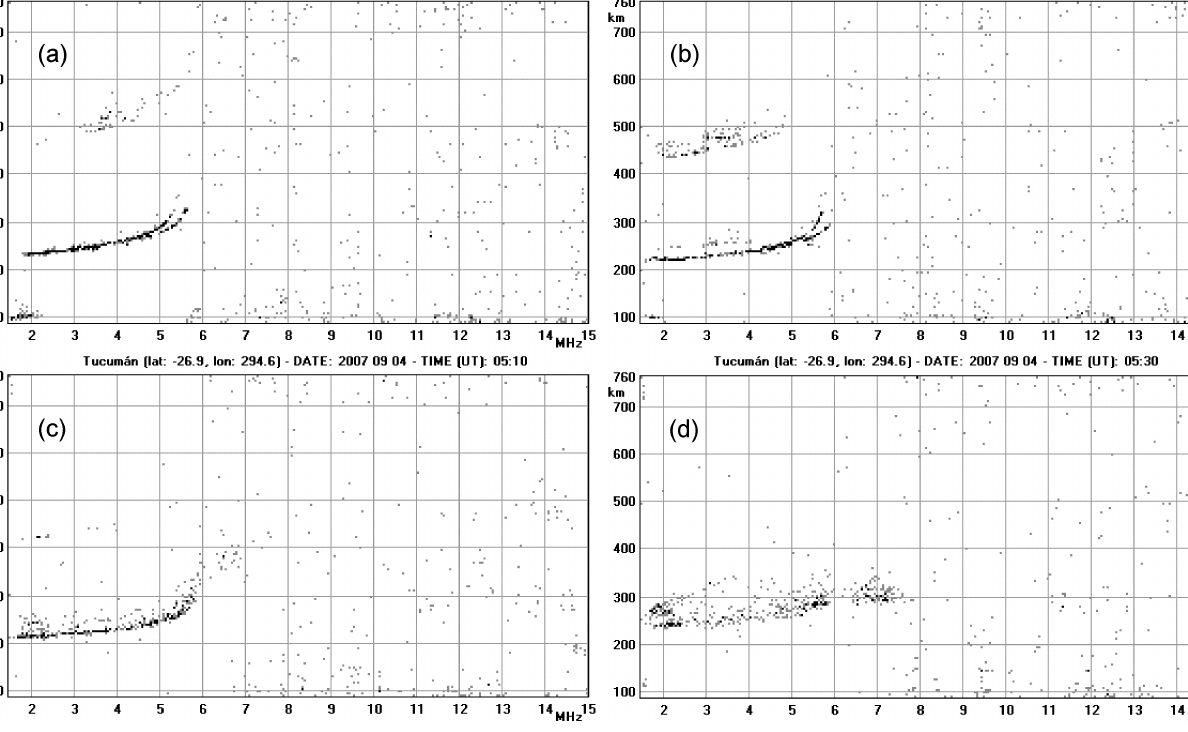
Fig. 1. Sequence of ionograms recorded on 4 September 2007 showing (a) diffuse trace in the second order mode, (b) ST appearance adjacent to the low-frequency end of the first order mode, (c) RSF commencement, and (d) RSF fully